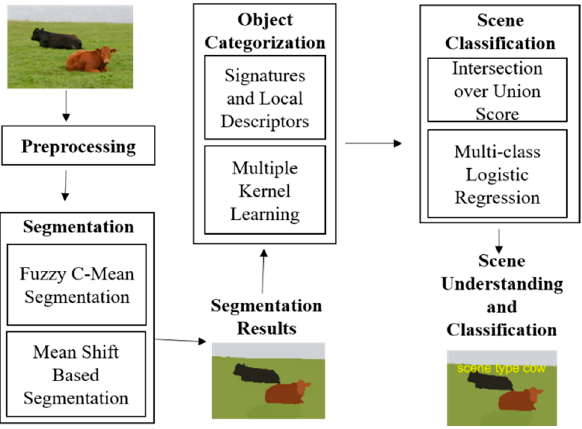
Figure 1. Overview of the proposed scene classification system using Multi-class Logistic Regression.